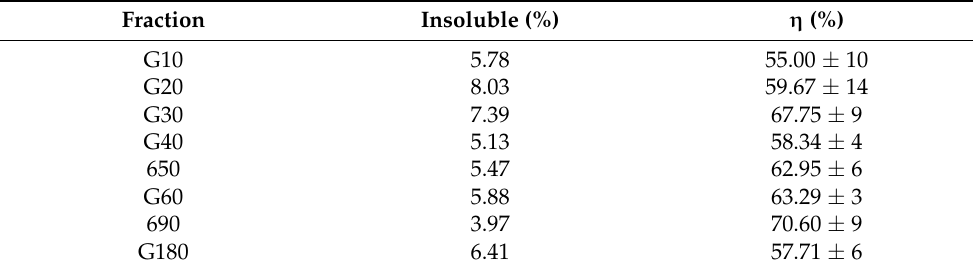
Table 2. Insoluble fraction and yield values obtained at 220 ◦ C at several reaction times.